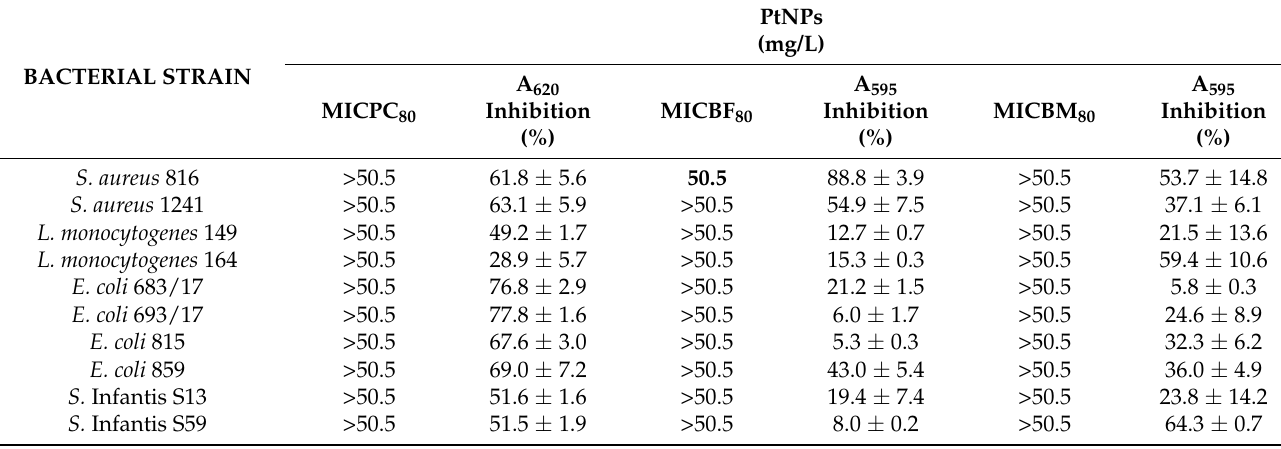
Table 2. Minimal concentrations inhibiting planktonic growth, biofilm formation and biofilm metabolic activity with their respective inhibitory rates of PtNPs for planktonic cells. Data represent the mean of at least three independent replicates. The significance of the results was verified by t -test ( p ≤ 0.05).